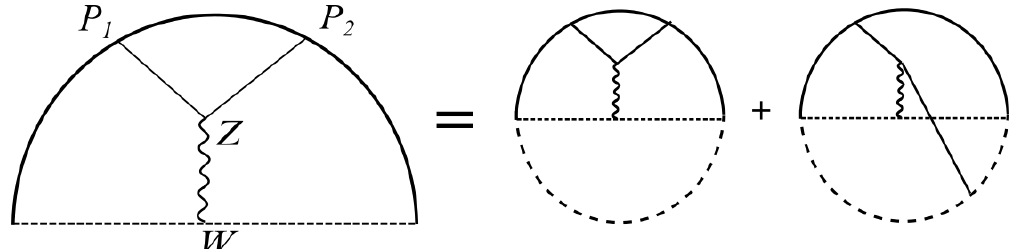
Figure 4 . The bulk exchange Witten diagrams can be written as a sum over two diagrams on full AdS d +1 . In the (cid:12)gure we show the Neumann case, Dirichlet would correspond to a minus sign on the